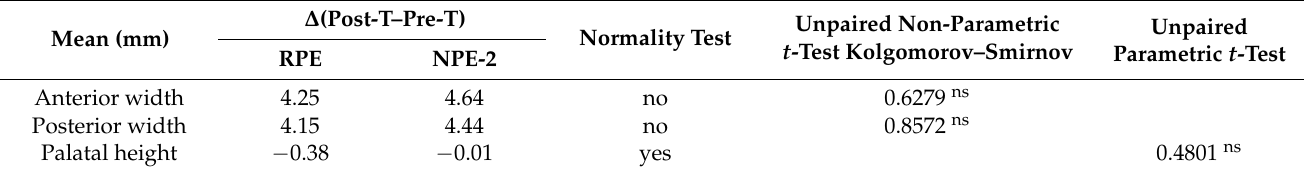
Table 2. Changes in frontal width, posterior width (Pont’s landmarks), and palatal height before treatment and after treatment in patients treated with NPE-2 and RPE.